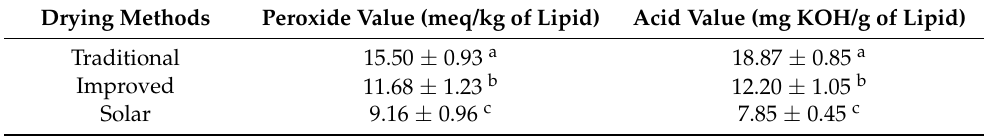
Table 2. Effect of the drying methods on the peroxide value and acid value of H. molitrix . Each value is expressed as a mean ± SD ( n = 3). Means with different superscripts within a column are significantly different ( p < 0.05).